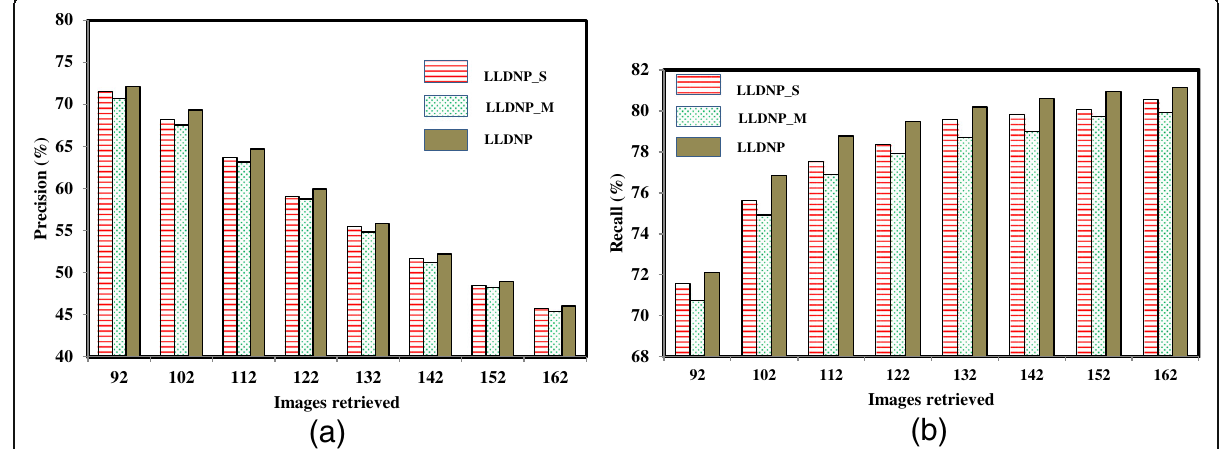
Fig. 12 Comparison of LLDNP_S, LLDNP_M, and LLDNP in terms of a precision and b recall on CUReT database. The performance of LLDNP_S is better than LLDNP_M. But LLDNP shows higher performance than LLDNP_S and LLDNP_M in terms of precision and recall on CUReT